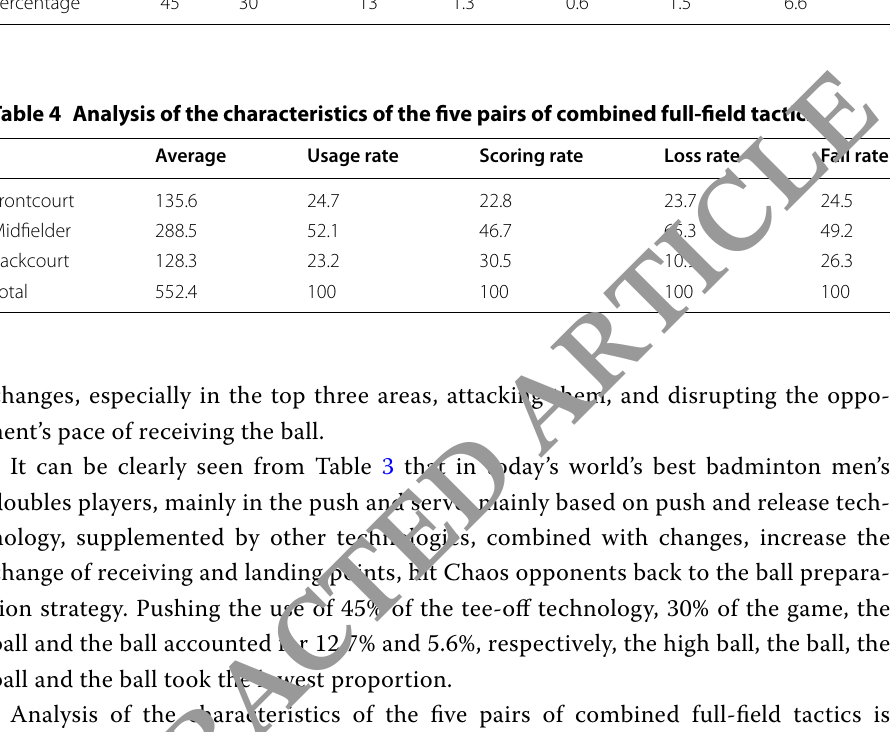
Table 3 Statistics on the use of receiving technology Push Open ball Smash High ball Pounce Number of beats